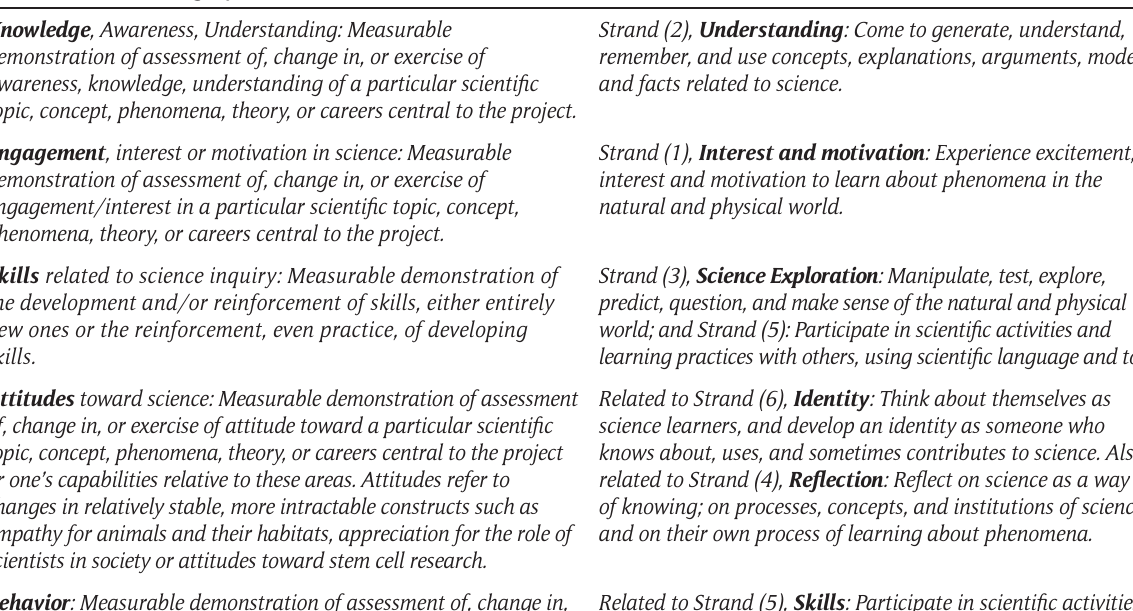
Table 1: Comparison of NSF Framework and LSIE strands. NSF Framework Category LSIE